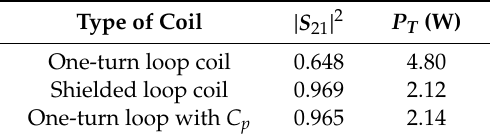
Table 3. Transmission e ffi ciency and transmitting power ( P T ) for 1 W reception at a resonant frequency of 6.78